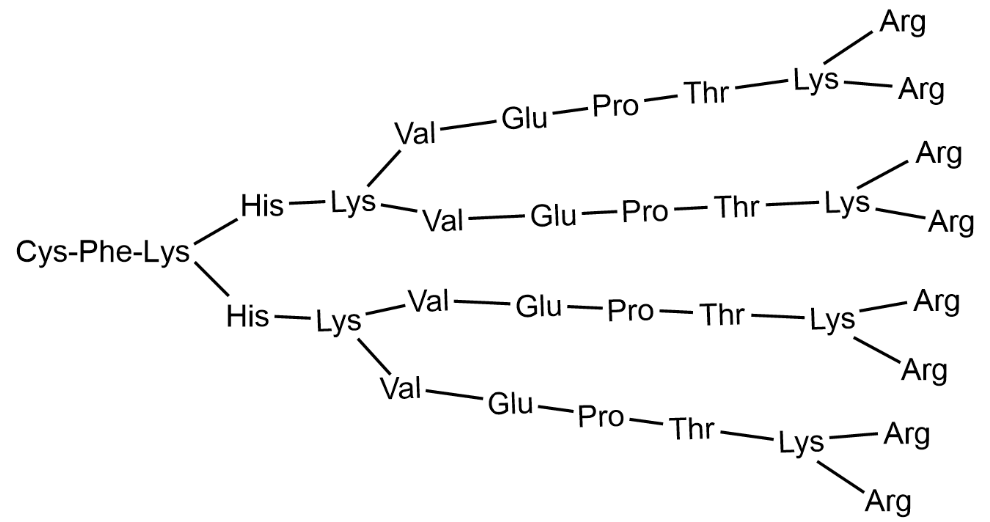
Figure 7. Structure of the cationic peptide dendrimer KK-46, usable as carrier of siCoV.